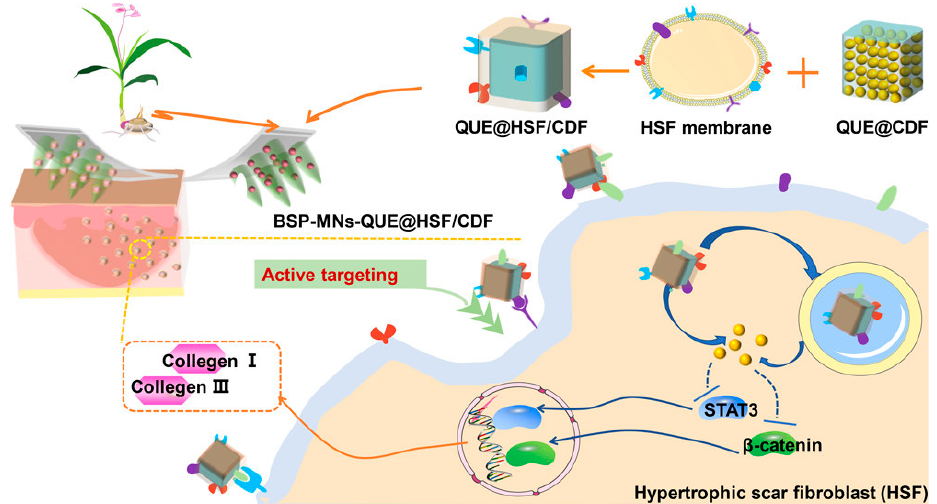
Figure 9. Schematic diagram of the administration of BSP-MNs-QUE@HSF/CDF, which can make active targeting hypertrophic scars (HSs). The HSs treatment efficacy was improved by reducing the expression of collagen I and III in HSs and regulating the pathways of β -catenin and STAT3 [98]. Reproduced with permission from Tong Wu, ACS nano; published by American Chemical Society, 2022.